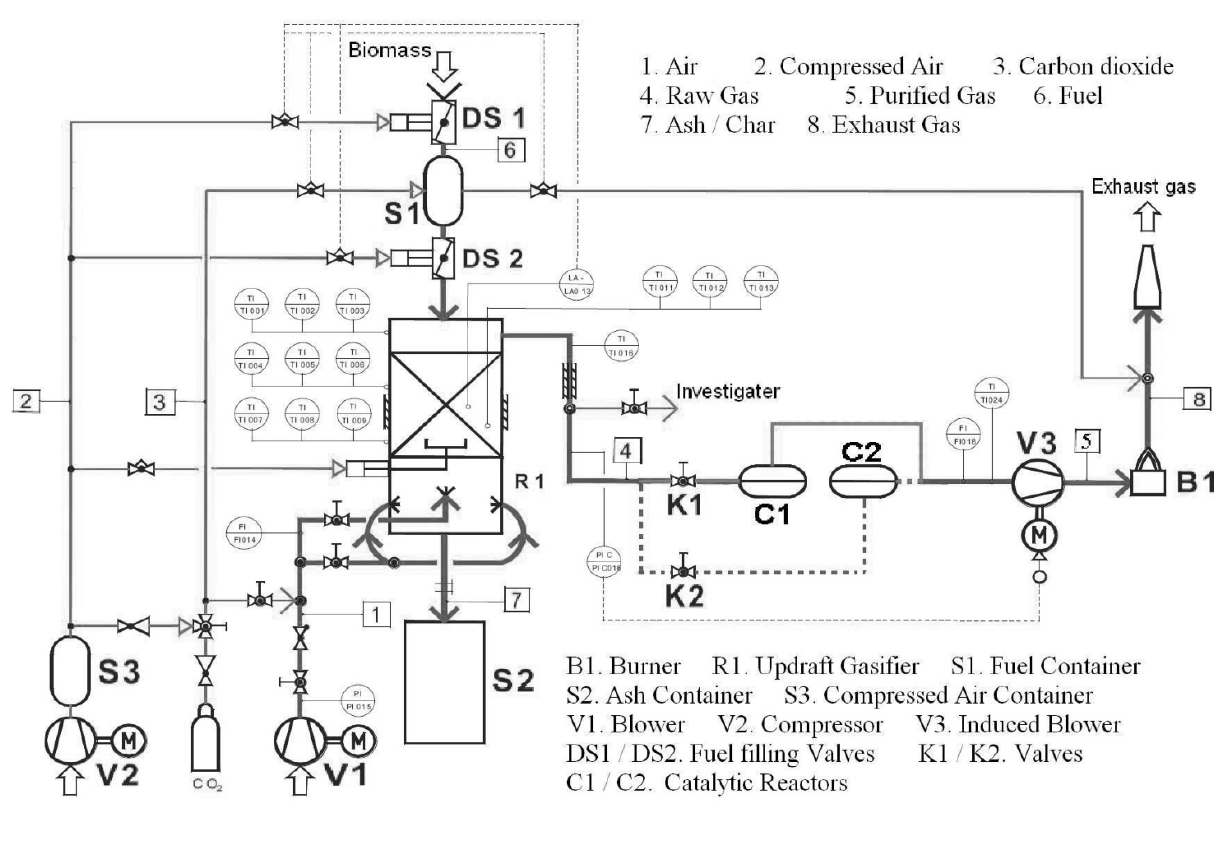
Figure 2. Flow chart of the updraft